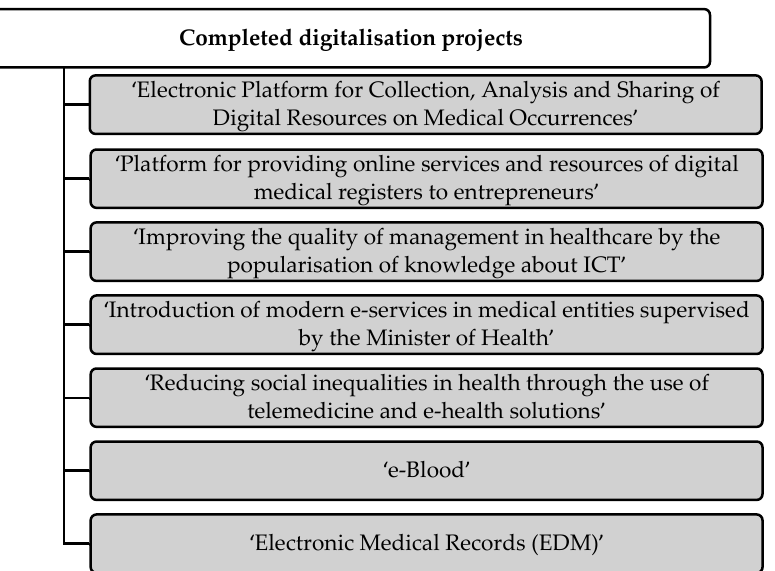
Figure 9. Existing solutions for digital transformation of the health sector [44].